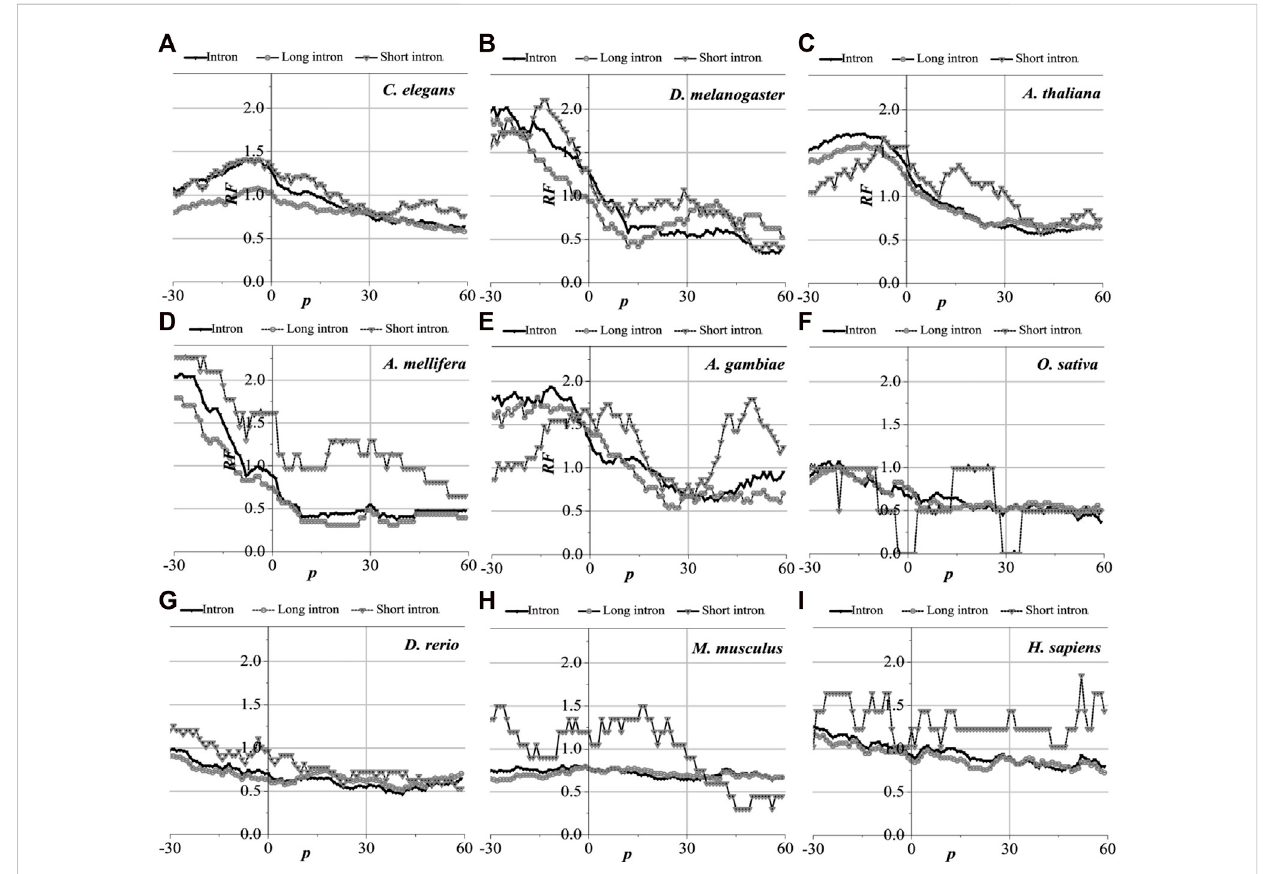
FIGURE 4 RF distributions around translation initiation site. The X-axis is the position of mRNA and the Y-axis represents the RF values. RF = 1 represents the average value of relative match frequencies